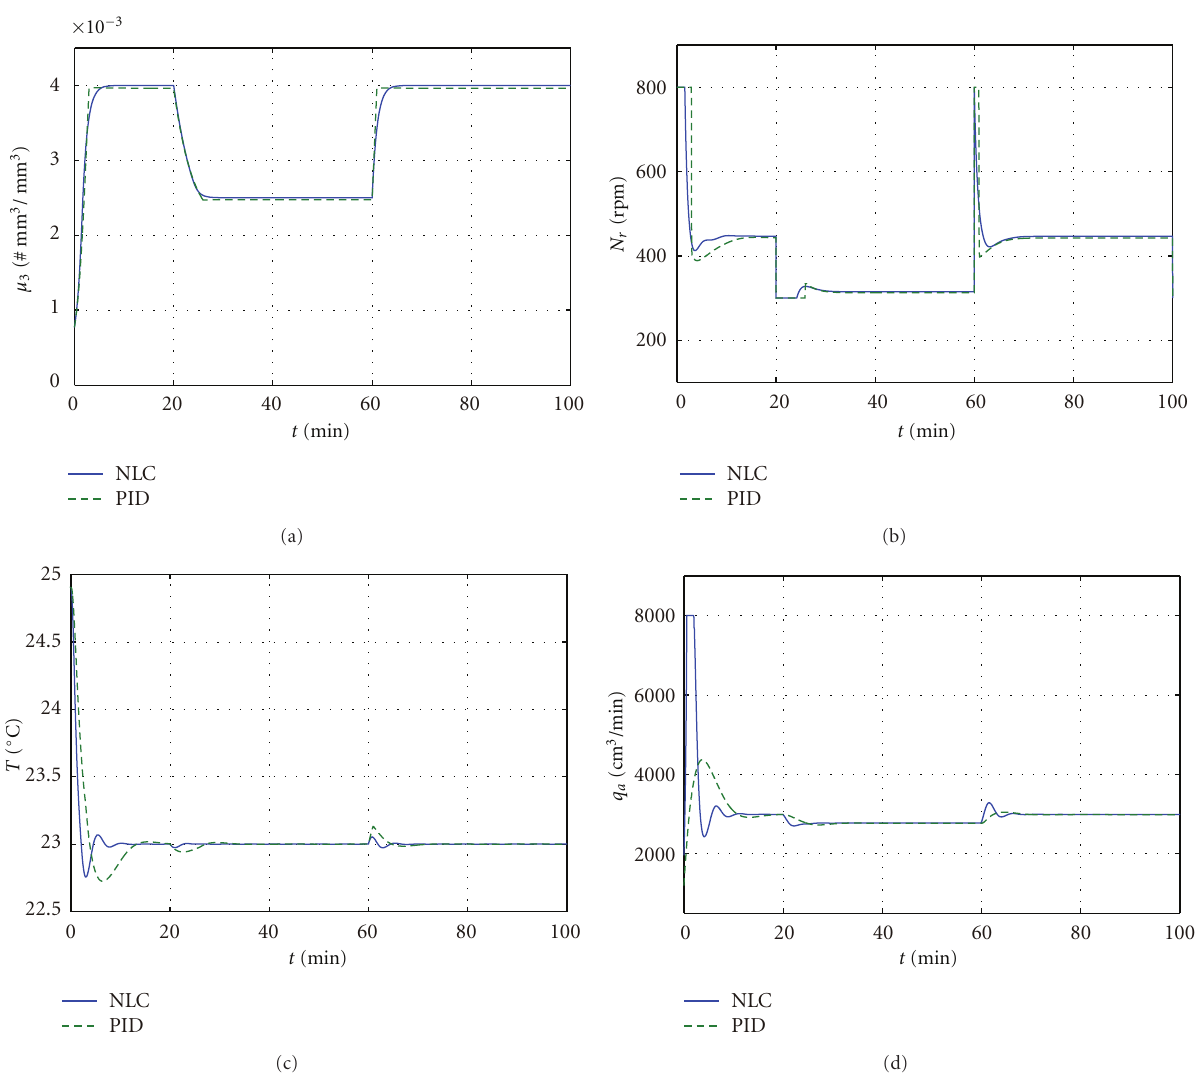
Figure 2: Closed-loop dynamic responses for the MIMO system when step changes in μ 3 are introduced.